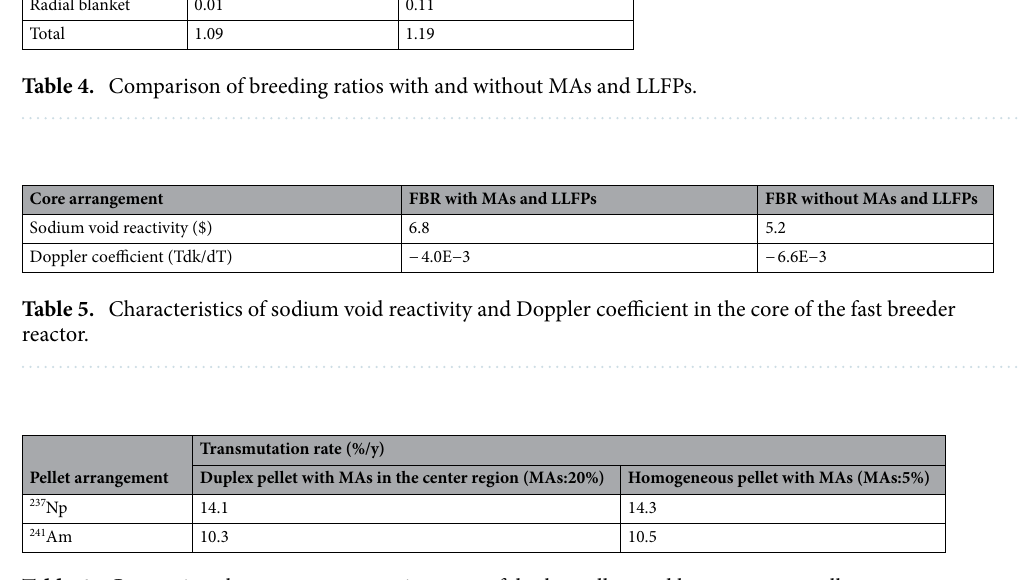
Table 6. Comparison between transmutation rates of duplex pellets and homogeneous